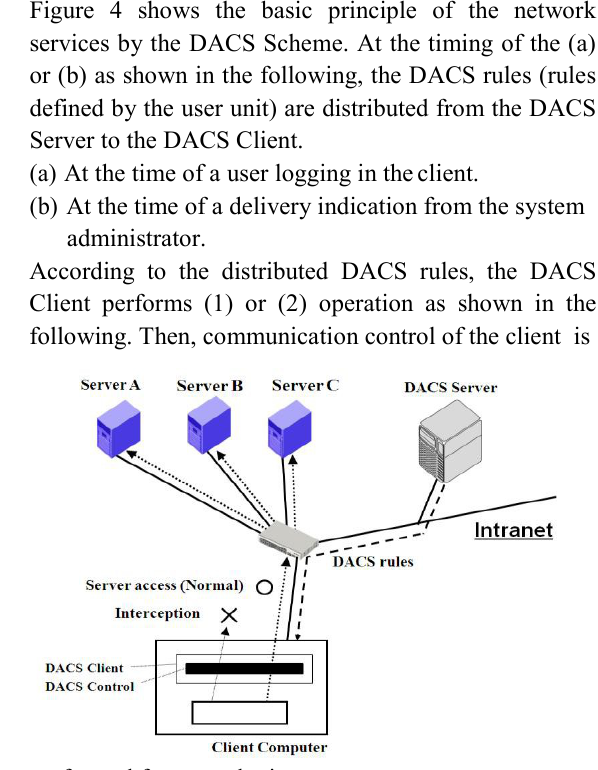
Figure 4. Basic Principle of the DACS